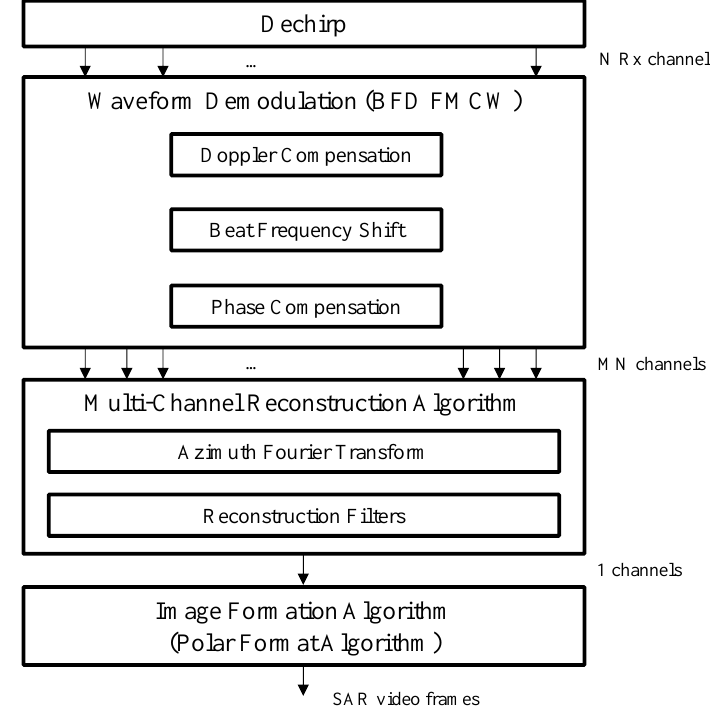
Figure 9. Signal processing block diagram for MIMO video SAR with a beat frequency division FMCW waveform. FMCW: frequency-modulated continuous wave; BFD: beat frequency